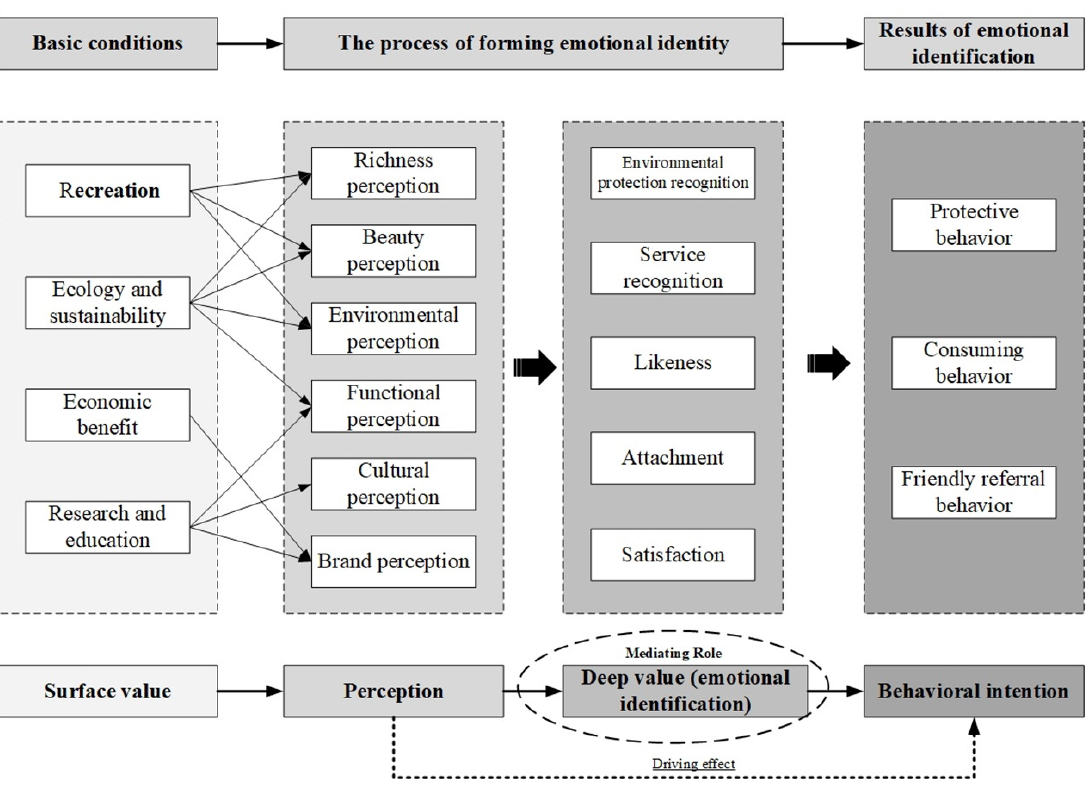
Figure 4. The association mechanism model.